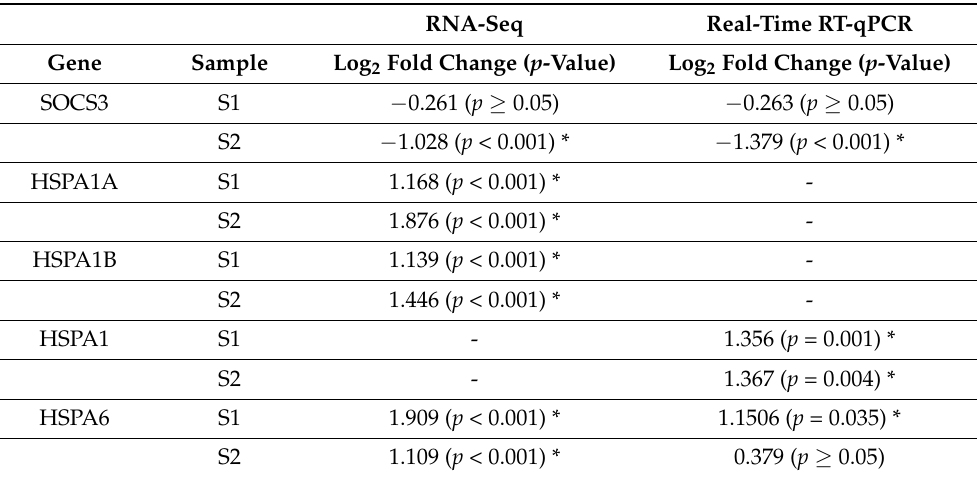
Table 4. Average log 2 fold change of selected human genes of interest by RNA-Seq and real-time RT-qPCR of HL-CZ cells expressing SARS-CoV-2 spike S1 and S2 subunits.